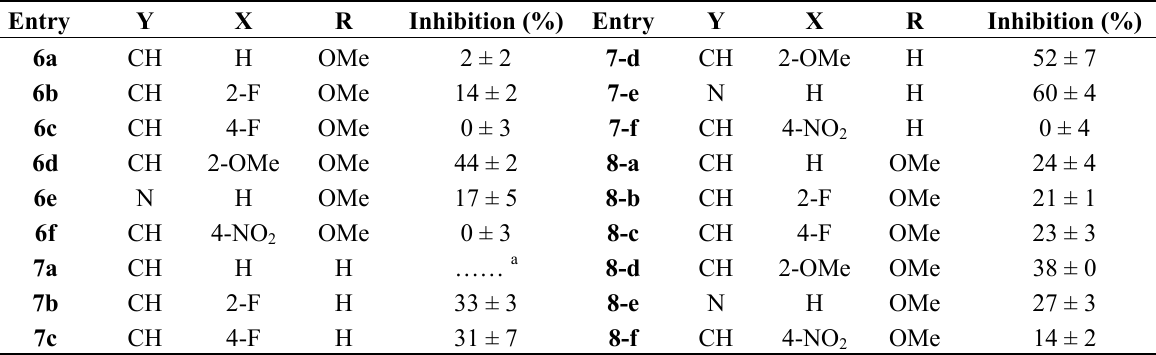
Table 3. Inhibition % for benzo[ b ]thiophene arylpiperazine